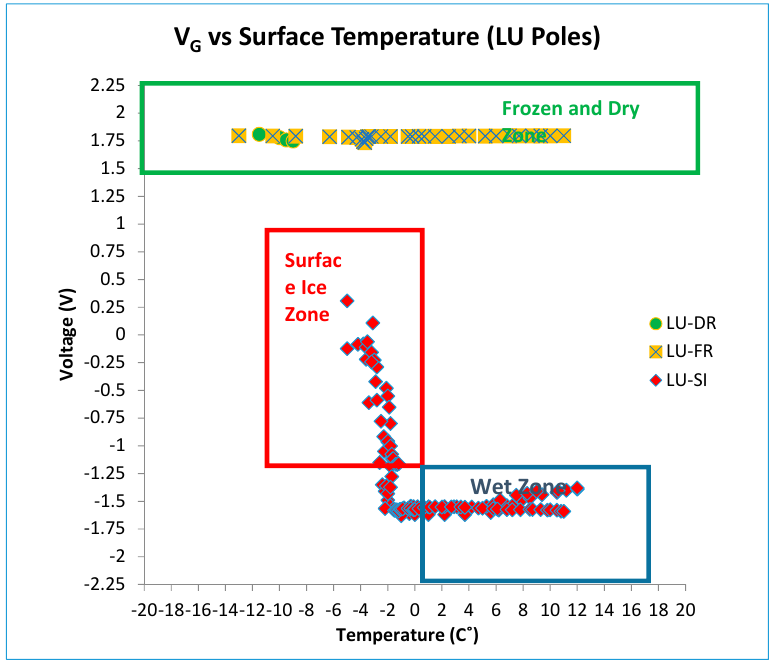
Figure 18. Zones of surface condition based on LU laboratory test results. Table 1. Voltage–temperature zones for various conditions.